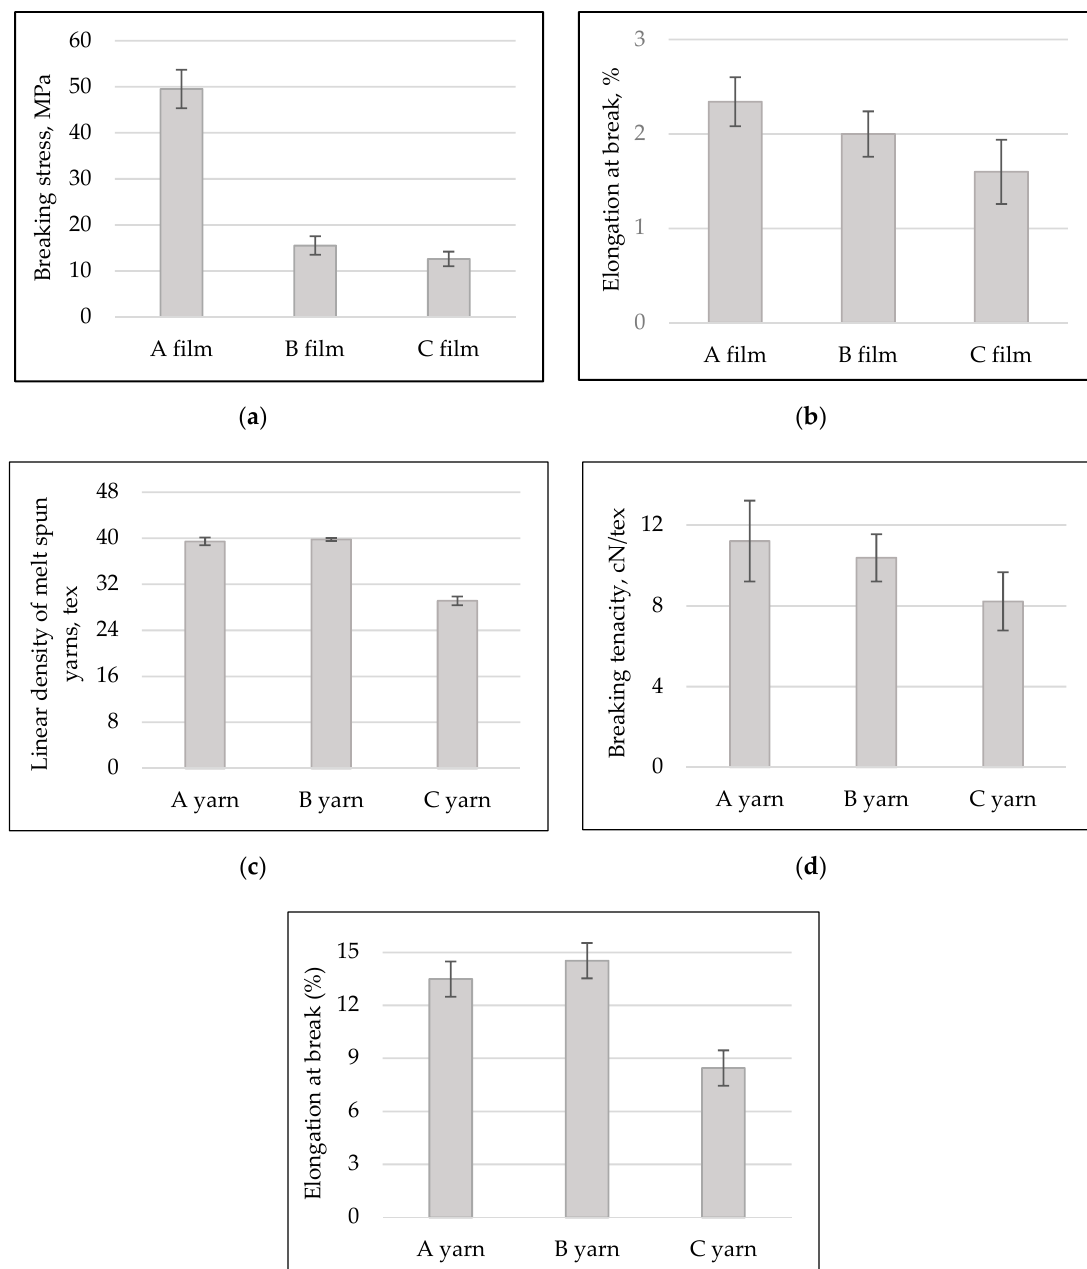
Figure 4. Influence of the modification of PLA granules with myrrh extract on: ( a ) PLA films breaking stress, MPa; ( b ) elongation at break, %; ( c ) melt-spun multifilament yarns linear density, tex; ( d ) breaking tenacity, cN/tex and ( e ) elongation at break, %.